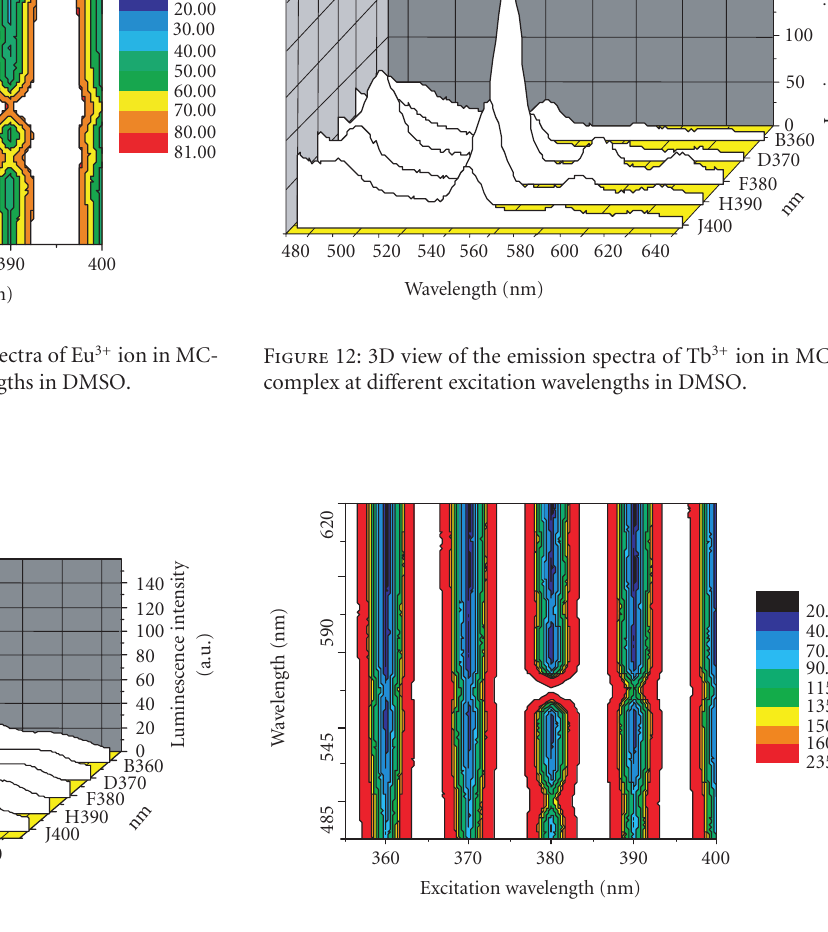
Figure 13: Contour view of the emission spectra of Tb 3+ ion in MC- Tb complex at di ff erent excitation wavelengths in